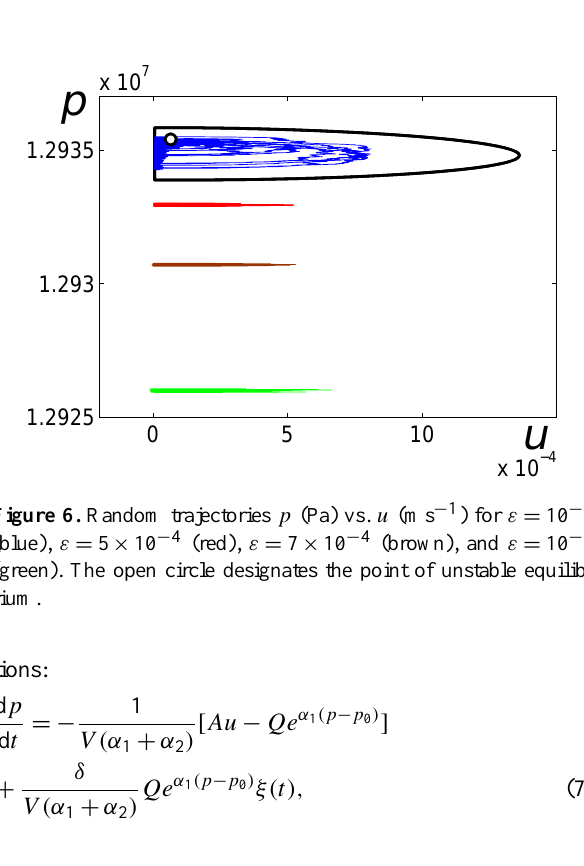
10 − 5 (red): (a) random trajec- ×